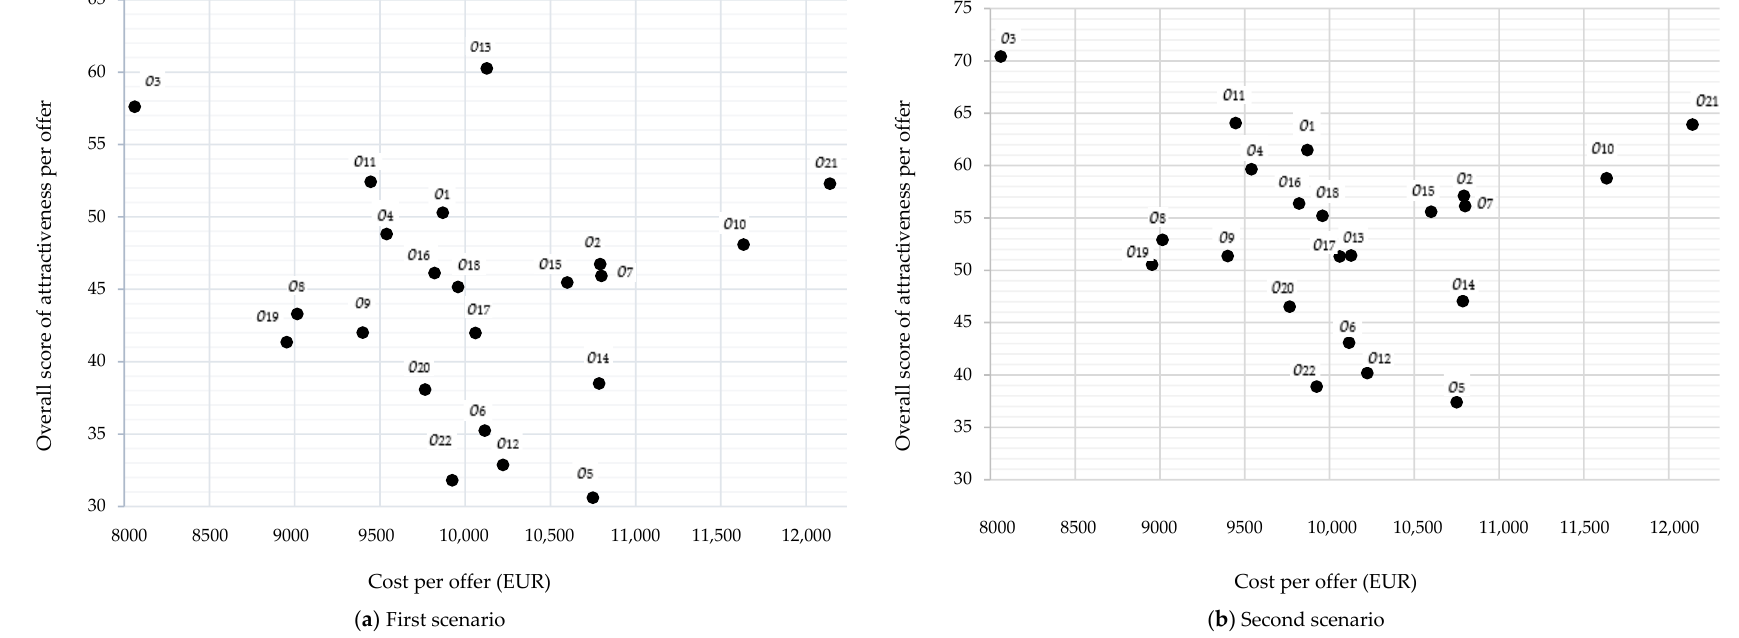
Figure 2. The position of offers in terms of cost and an overall score of attractiveness.